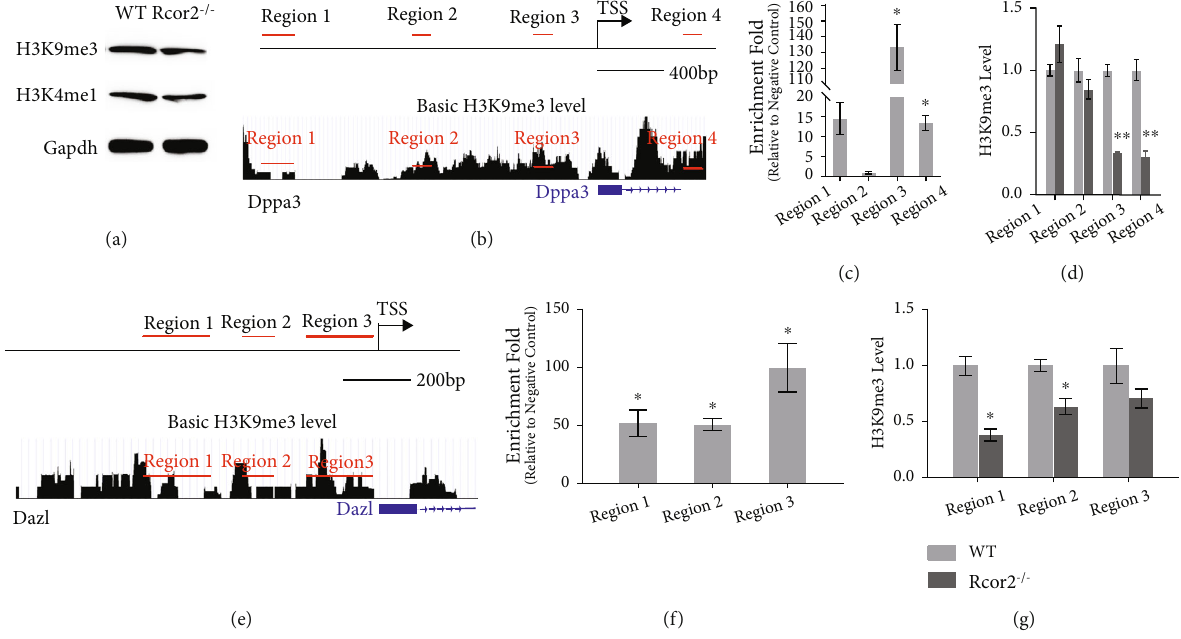
Figure 5: Rcor2 inhibits Dppa3 and Dazl expression by enhancing H3K9me3 on their promoters. (a) The protein level of H3K4me1 and H3K9me3 in WT and Rcor2 -/- mESCs. (b, e) Diagrams of the tested regions by ChIP-qPCR on Dppa3 (b) and Dazl (e) genes and basal H3K9me3 level on Dppa3 (b) and Dazl (e) genes in mESCs (data from GEO: GSM32218, generated by ENCODE [27]). (c, f) ChIP- qPCR shows the enrichment of Rcor2 on Dppa3 (c) and Dazl (f) promoters at the tested regions, relative to their respective negative control regions, which are located in gene bodies (not shown). Data are expressed as mean ± SEM , n = 3 , ∗ p < 0 : 05 . (d, g) ChIP-qPCR shows the H3K9me3 level at the tested regions of Dppa3 (d) and Dazl (g) genes in WT and Rcor2 -/- mESCs. Data are expressed as mean ± SEM , n = 3 , ∗ p < 0 : 05 , ∗∗ p < 0 : 01 , ∗∗∗ p < 0 : 001